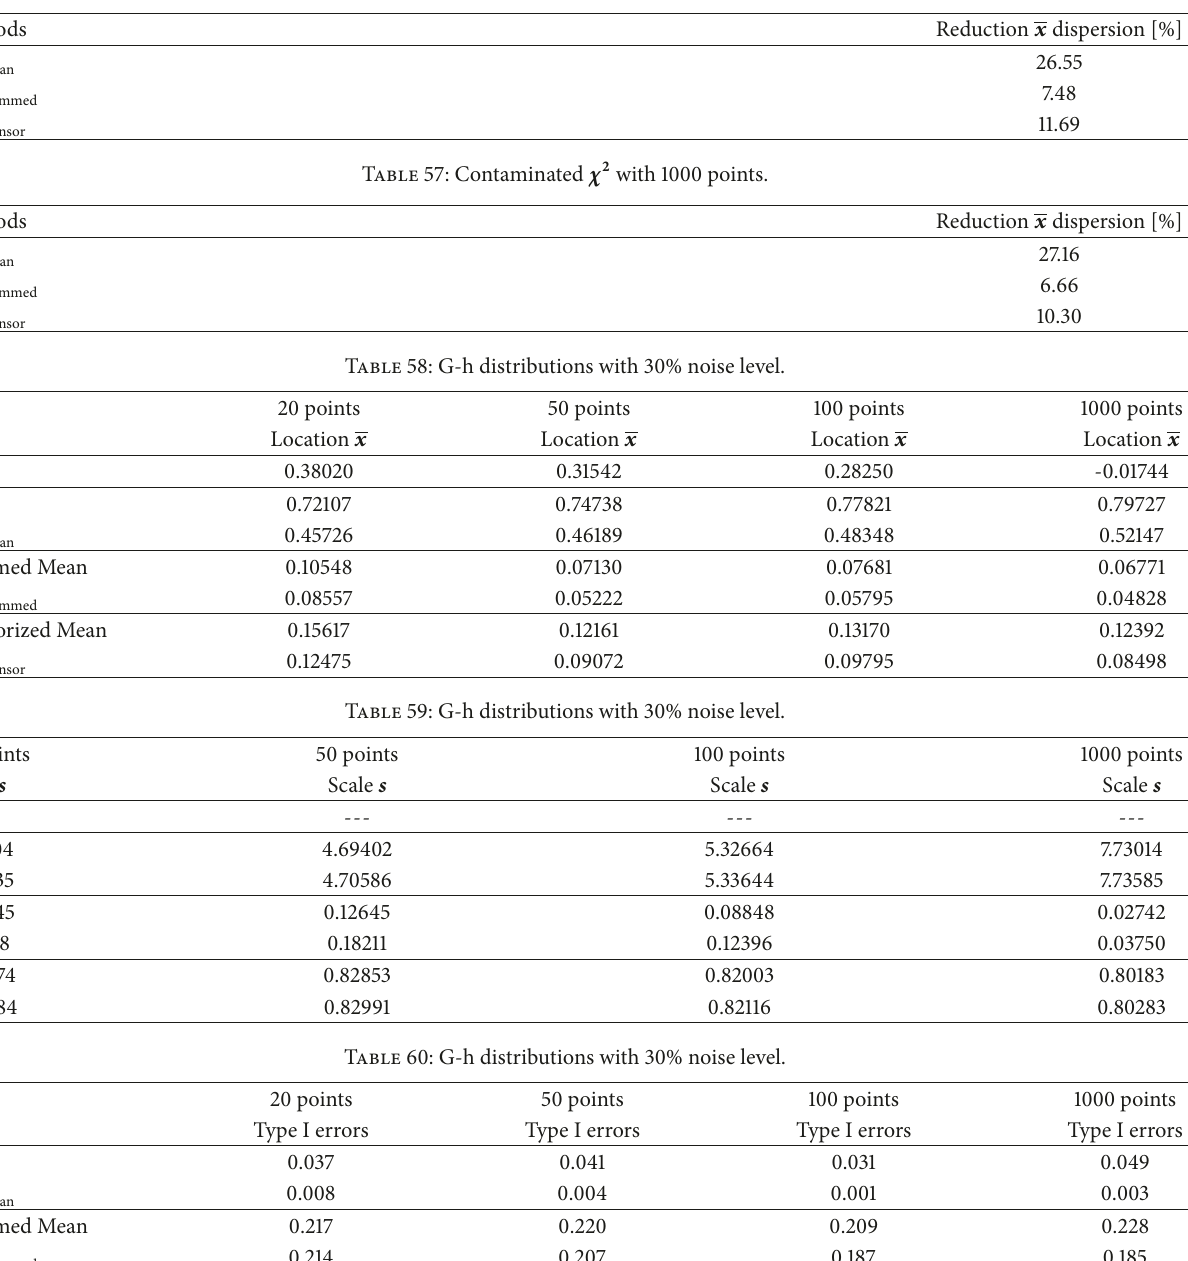
Table 56: Contaminated 𝜒 2 with 100 points.